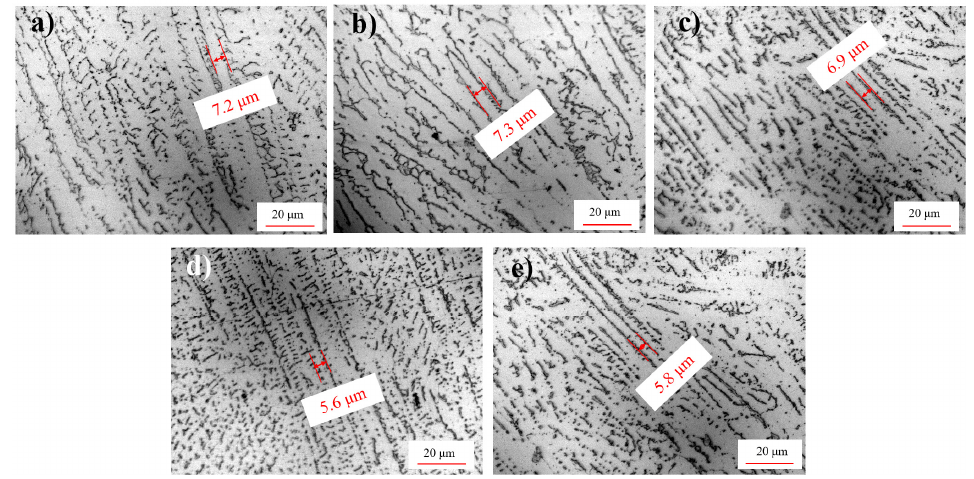
Figure 10. Columnar crystal morphology of weld fusion line: ( a – e ) U 0 –U 4 , respectively.